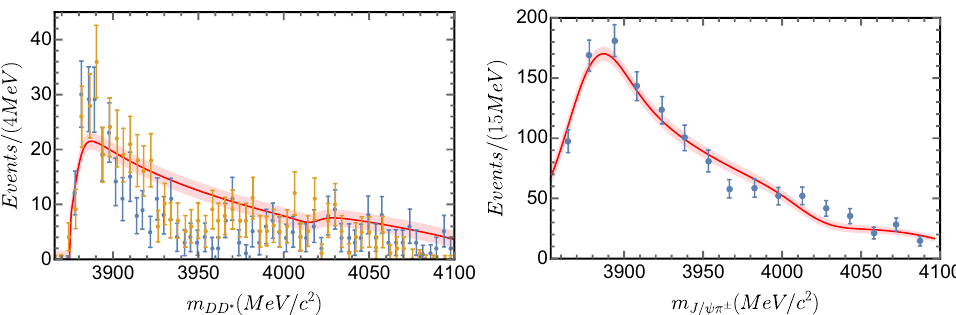
Figure 1: Line shapes for D ¯ D ∗ (left panel) and π J /ψ (right panel) invariant (cid:112) s = 4.26 GeV for the reactions e + e − → π ± ( D ¯ D ∗ ) ∓ and mass spectrum at e + e − → π + π − J /ψ , respectively. Experimental data are from Ref. [ 8,34 ] , respectively. The theoretical line shapes have been convoluted with the experimental resolution. The line-shape’s 68% uncertainty is shown as a shadowed area.